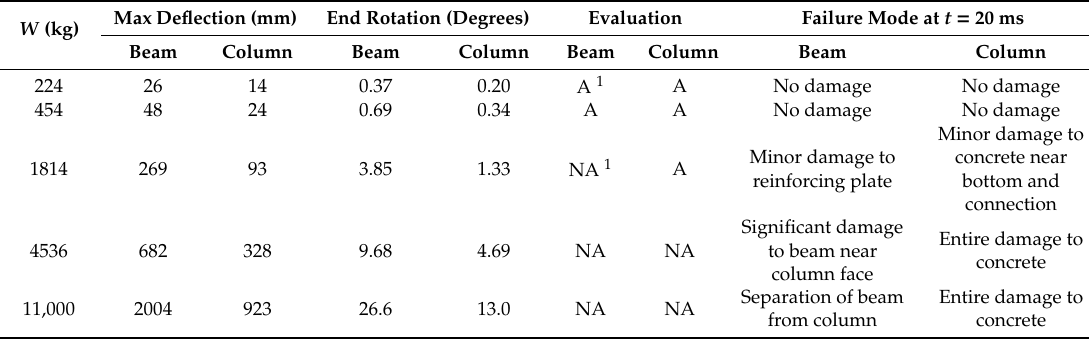
Table 4. Plate-reinforced large CFT